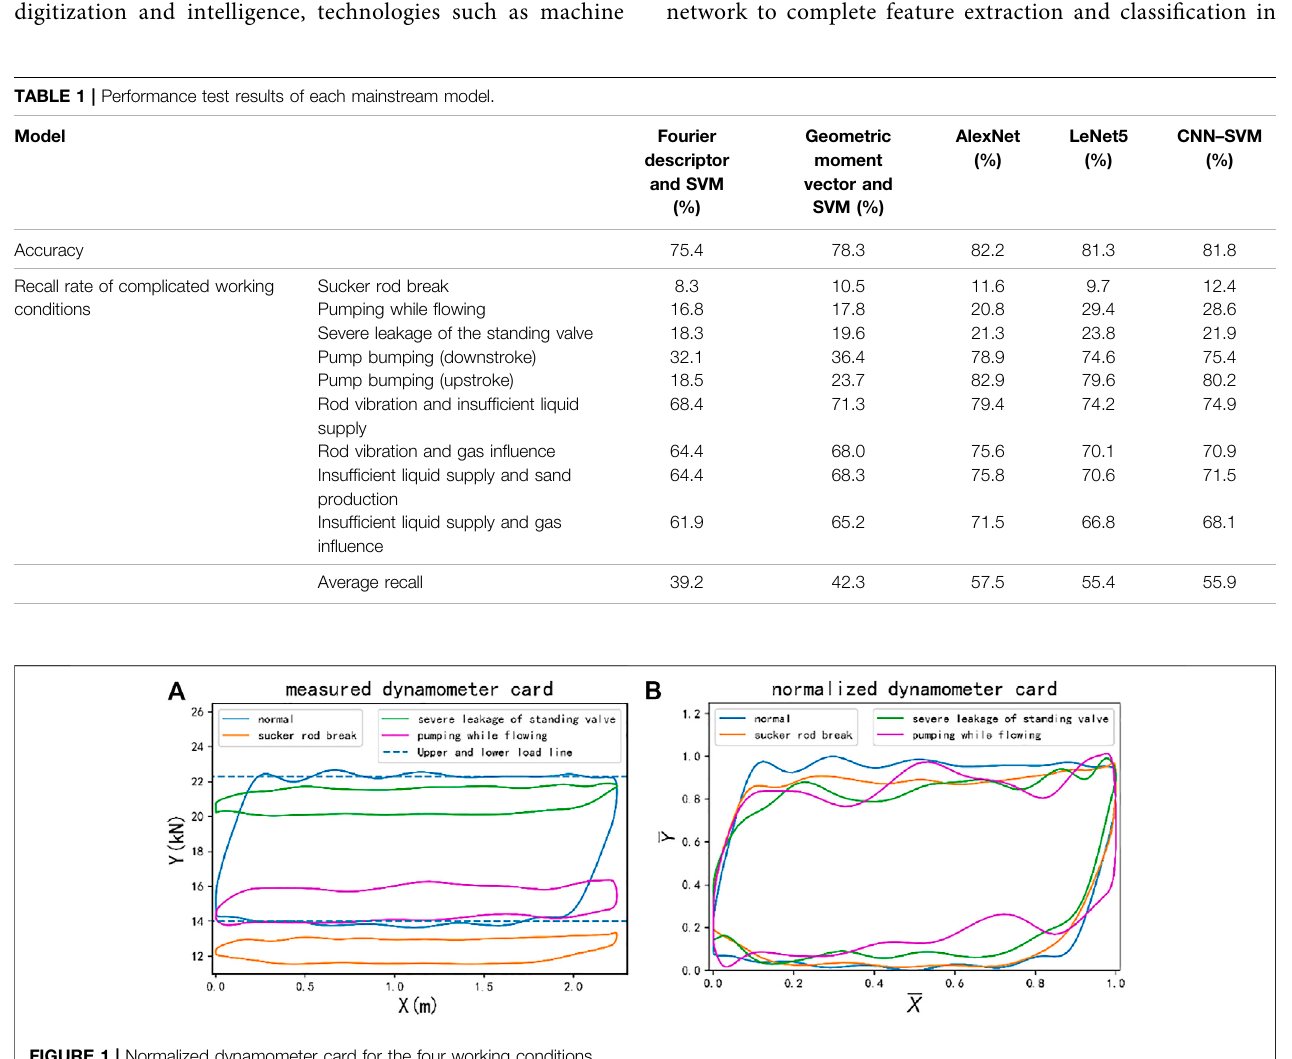
Frontiers in Earth Science |